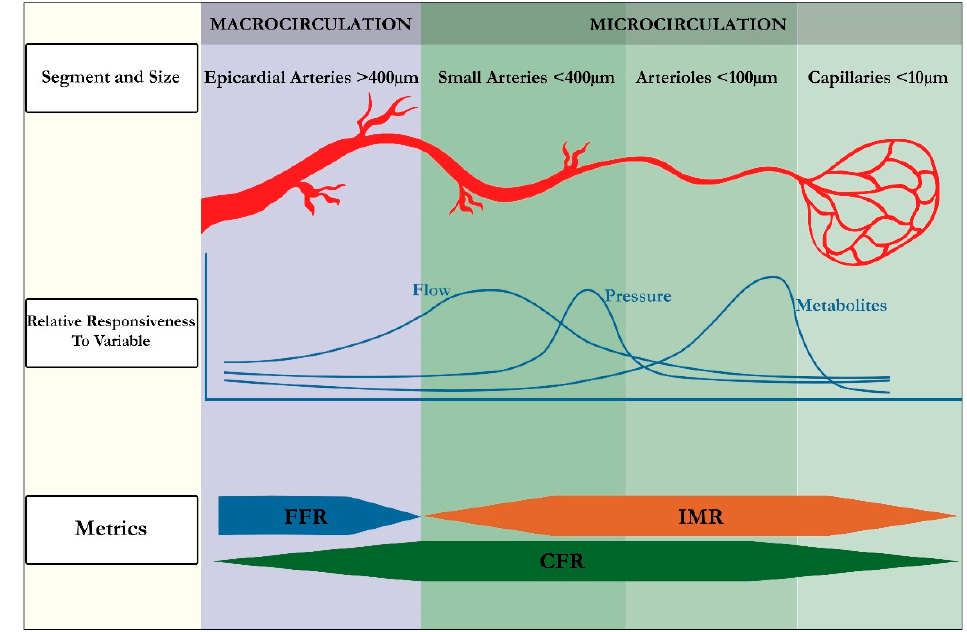
Figure 1. Anatomy and Physiology of Coronary Circulation. FFR = fractional flow reserve; IMR = index of microcirculatory resistance; CFR = coronary flow reserve.